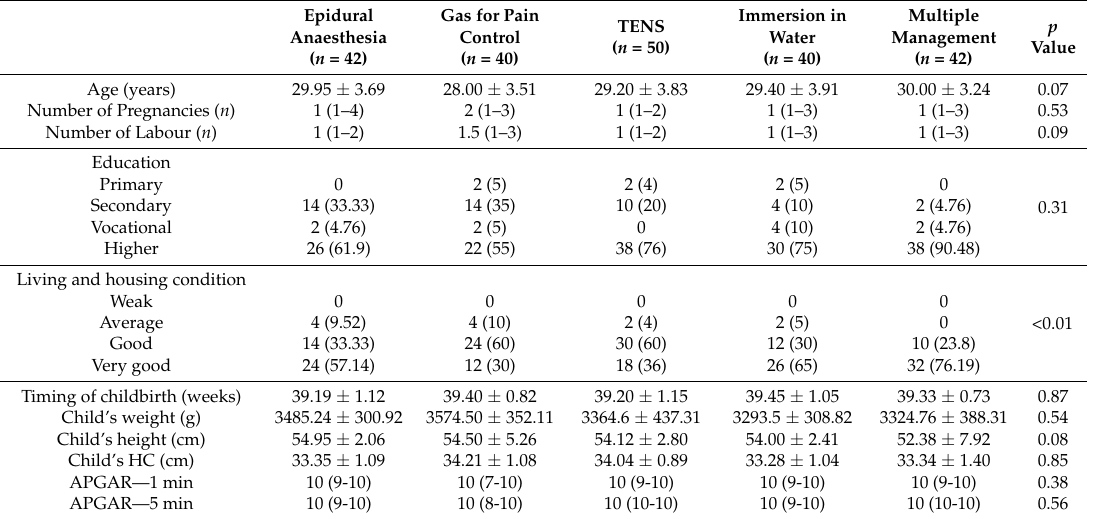
Table 1. Clinical characteristics of delivering women stratified by chosen pain relief method.